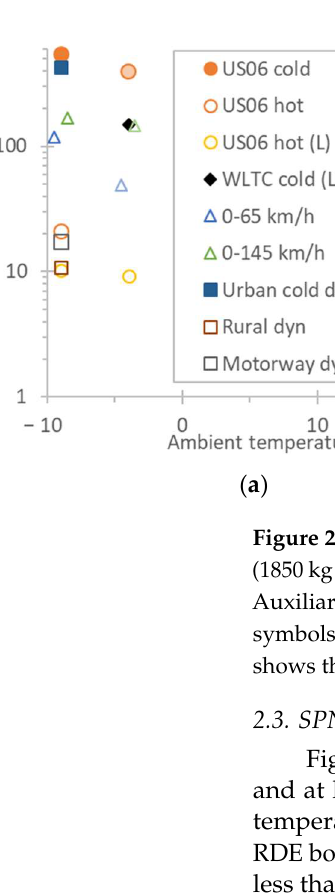
Figure 2. Emissions for various tests at different ambient temperatures. All tests with 84% payload (1850 kg test mass), except those with “L” and the −4 °C tests where the test mass was lower (1550 kg). Auxiliaries were activated only at the −9 °C tests. Solid symbols are cold start tests, while open symbols are hot start tests. Lighter colors indicate tests with lower payload (mass). The dotted line shows the limit for the type approval cycle WLTC. ( a ) HC. ( b ) NO x .